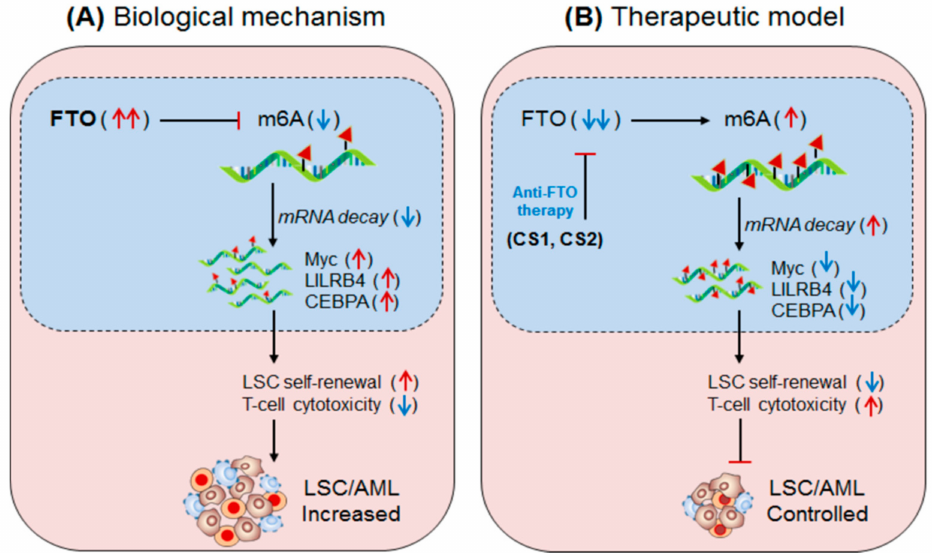
Figure 6. Therapeutic model targeting m6A-eraser ‘FTO’ in controlling LSC progression by enhancing anti-tumour immunity. ( A ) Biological mechanism: FTO is aberrantly expressed in AML, especially LSC populations, and facilitates its progression. Mechanistically, the FTO enhance the expression of its target LILRB4 (immune checkpoint) and other Myc and CEBPA genes via its m6A-demethylase activity by inhibiting m6A-reader protein YTHDF2-mediated mRNA-decay mechanism, causing decreased T-cell activity and increased self-renewal capacity, resulting in enhanced LSC progression. ( B ) Therapeutic model: Anti-FTO therapy: The two synthetic small-molecule inhibitors of FTO (CS1 and CS2) selectively binds to the FTO domain and inhibits its demethylase activity, leading to decreased expression of its target (LILRB4, MYC and CEBPA) mRNA via reducing YTHDF2-mediated mRNA-stability. The decreased expression of the targeted gene ultimately enhances T-cell cytotoxicity and immune evasion and thereby reduced self-renewal capacities, resulting in better control over LSC